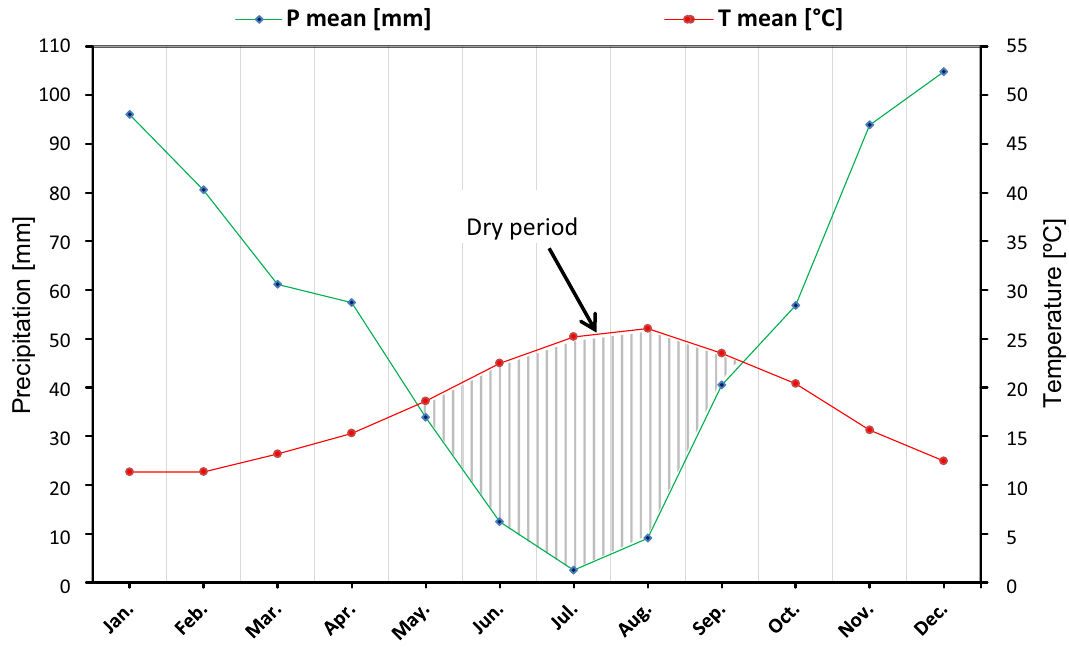
Fig. 3 Ombro-thermal chart of the Salin meteorological station